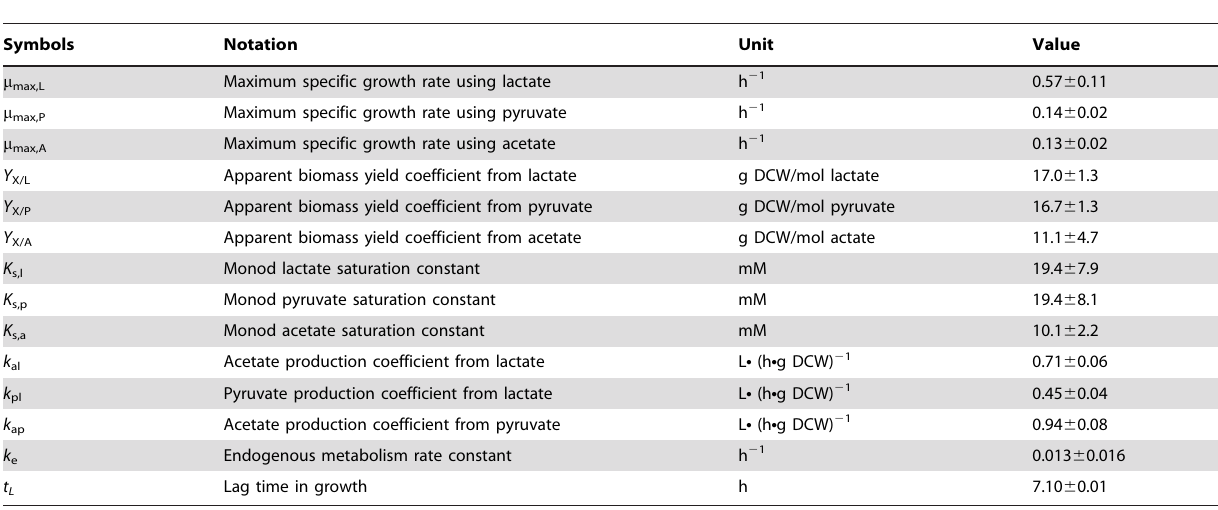
Table 1. Parameters estimated in the empirical Monod